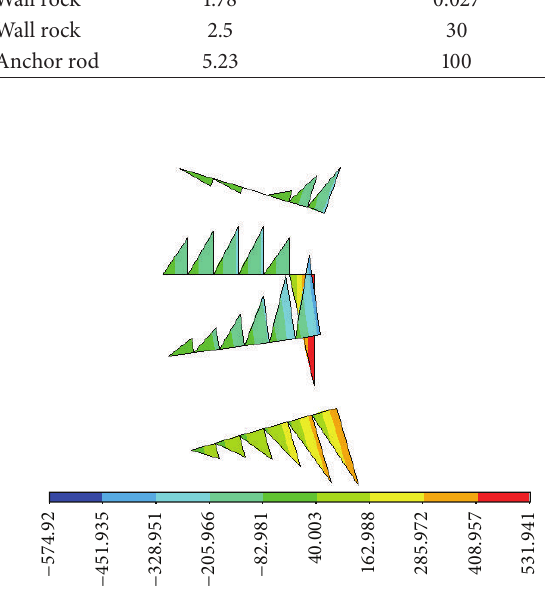
Figure 6: Axial force diagram after excavation.